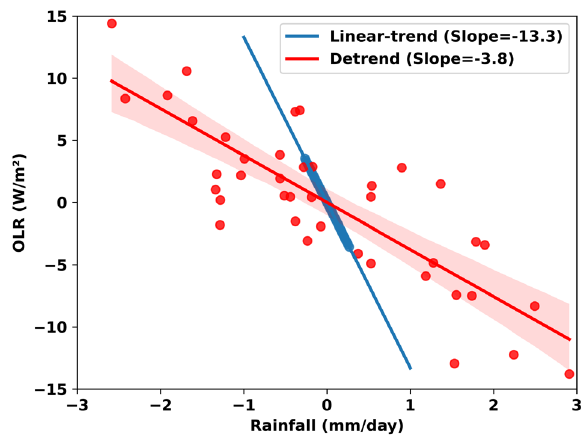
Fig. 2 Trends in rainfall and OLR. Scatter plot between detrend values of rainfall and OLR (red dots) and red shade indicating 95% con fi dence level. The blue line indicates the linear trend of rainfall and